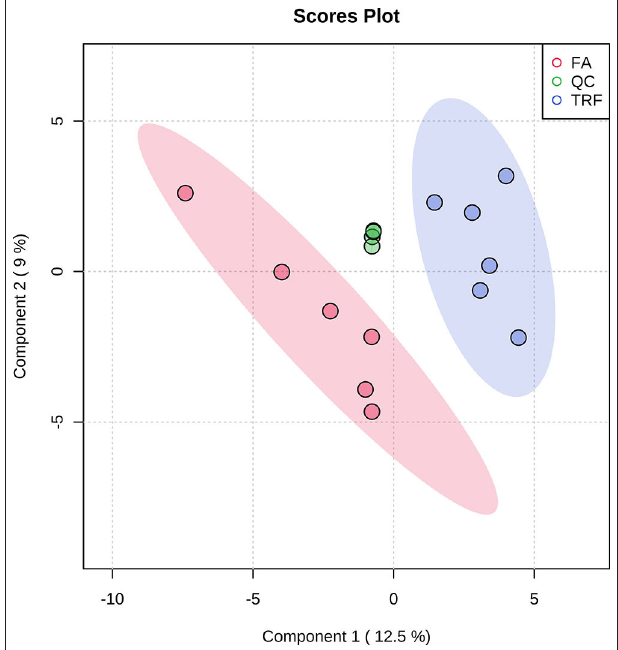
FIGURE 4 | Partial least squares discriminant analysis (PLS-DA) score plot of colonic metabolites (both ESI + and ESI-) of growing pigs in the FA and TRF groups. FA, free access group; TRF, time-restricted feeding group; QC, quality control. The ellipse represents the 95% confidence interval of each group.